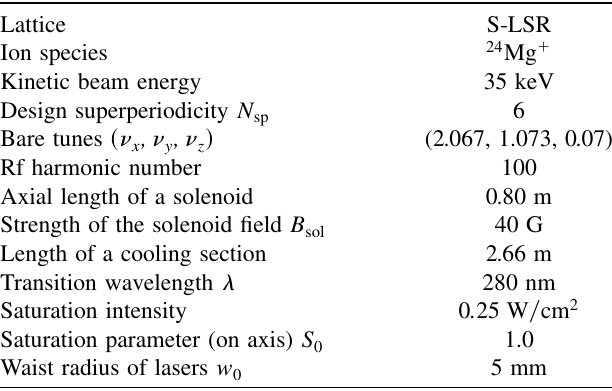
TABLE II. Parameters for laser-cooling